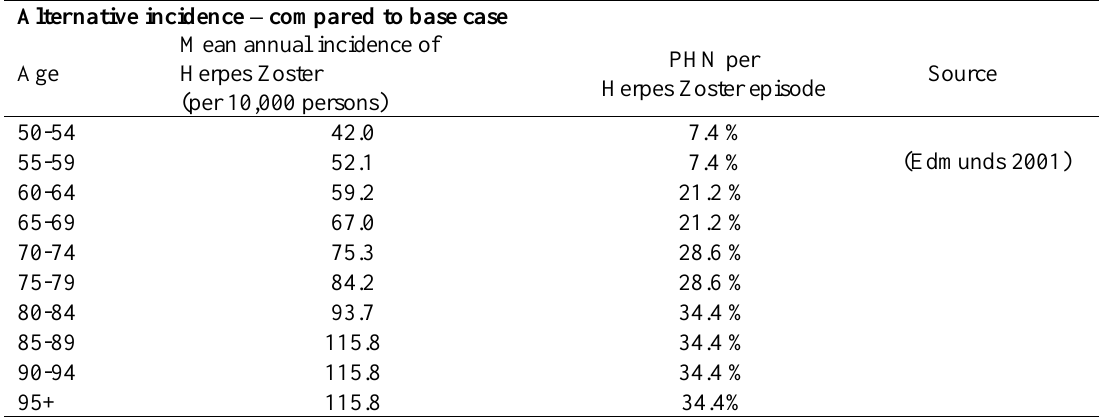
Deterministic sensitivity